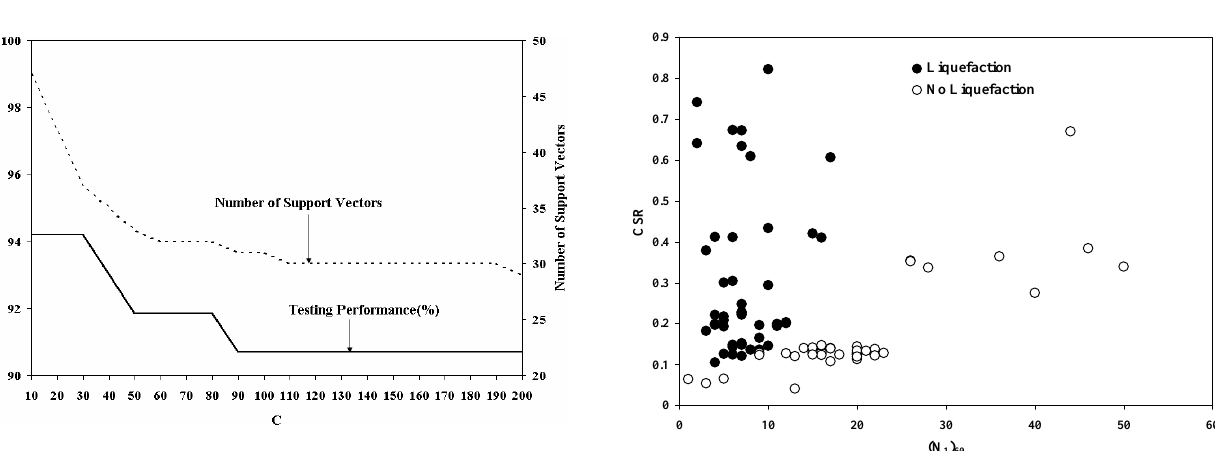
Figure 9. Plot between PGA and (N 1 ) 60 for global data using ANN model. Fig. 9. Plot between PGA and (N Figure 11. Plot between CSR and (N 1 ) 60 for MODEL I using radial basis function Fig. 11. Plot between CSR and (N 1 ) 60 for MODEL I using radial 1 ) 60 for global data using ANN model. basis function for training dataset. for training dataset.